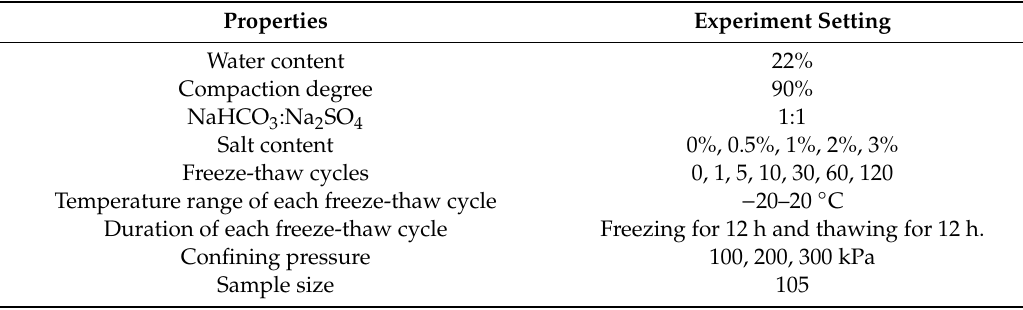
Table 1. Sample properties and design of freeze-thaw cycle